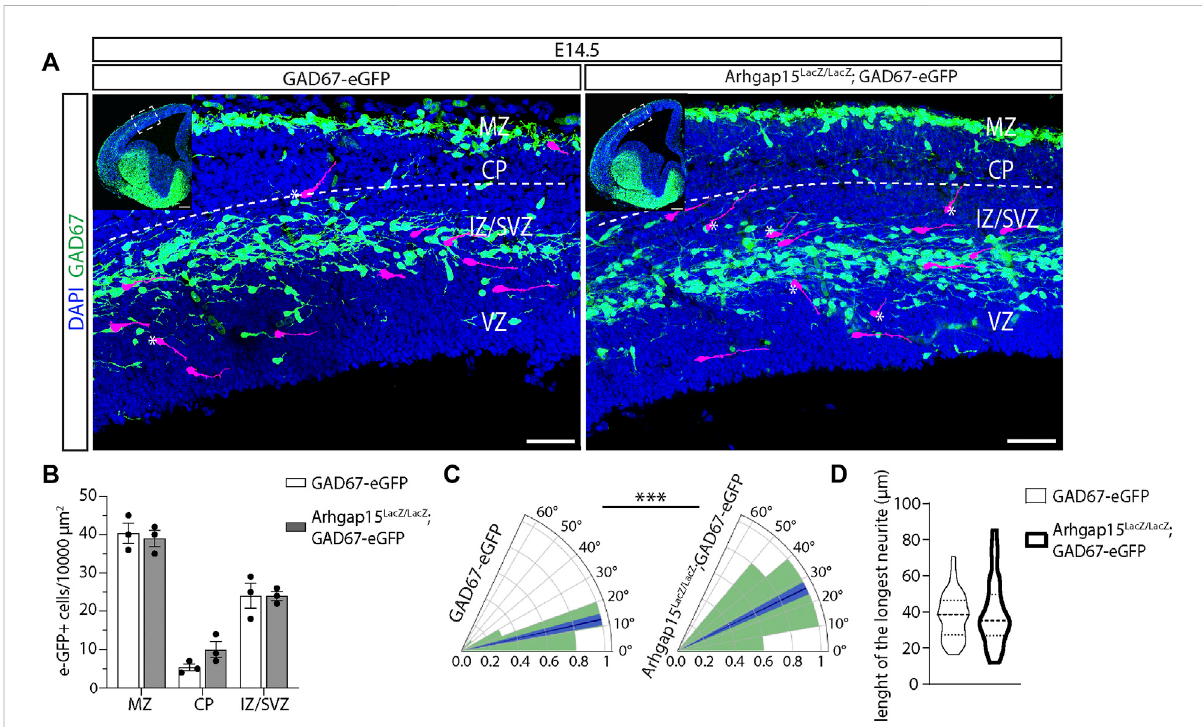
FIGURE 4 CIN tangential migration in the embryonic cortex. (A) Maximum intensity projections of z-stack images (10 serial image planes; z step size = 1 µm) of the neocortex of E14.5 GAD67-eGFP (control) and Arhgap15 LacZ/LacZ ; GAD67-eGFP brains. Inserts show the analyzed cortical region. Some eGFP-positive neurons are highlighted in magenta to improve visualization. The dashed line represents the canonical CINs tangential migratory route, parallel to the pia. * indicates tangentially migrating CINs deviating from the canonical trajectory. Scale bars: 50 µm (main panels) and 200 µm (inserts). (B) Average density of eGFP-positive neurons in the MZ, CP, and IZ/SVZ of E14.5 GAD67-eGFP and Arhgap15 LacZ/LacZ ; GAD67-eGFP embryos. p (from MZ to IZ/SVZ) = 0.8, 0.2, 0.99. (C) Polar plots showing the distribution (expressed as normalized frequency) of angles measured betweentangentiallymigratingCINleadingprocessesandthelineparalleltothepiainE14.5 GAD67-eGFP and Arhgap15 LacZ/LacZ ; GAD67-eGFP brains. The dark blue line represents the average angle, the light blue area represents SEM. p = 2.9 × 10 − 4 . (D) Average length of the longest neurite in E14.5 GAD67-eGFP and Arhgap15 LacZ/LacZ ; GAD67-eGFP migrating CINs. p = 0.16. At least 50 neurons from 3 different embryos were analyzed for each genotype. p -values were calculated using unpaired Mann – Whitney test. *** = p < 0.001. MZ, marginal zone; CP, cortical plate; IZ, intermediate zone; SVZ, subventricular zone; VZ, ventricular